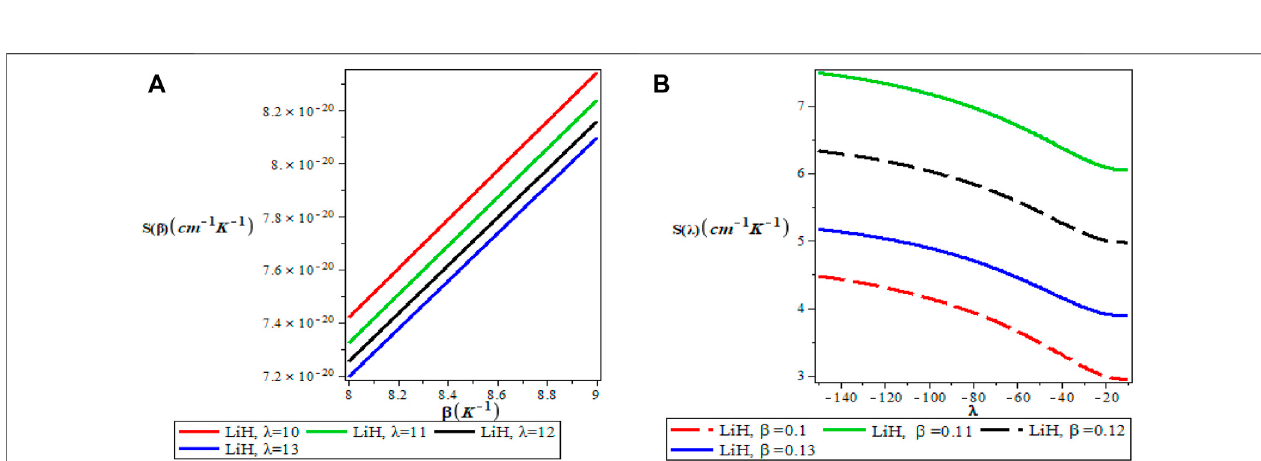
Frontiers in Physics |